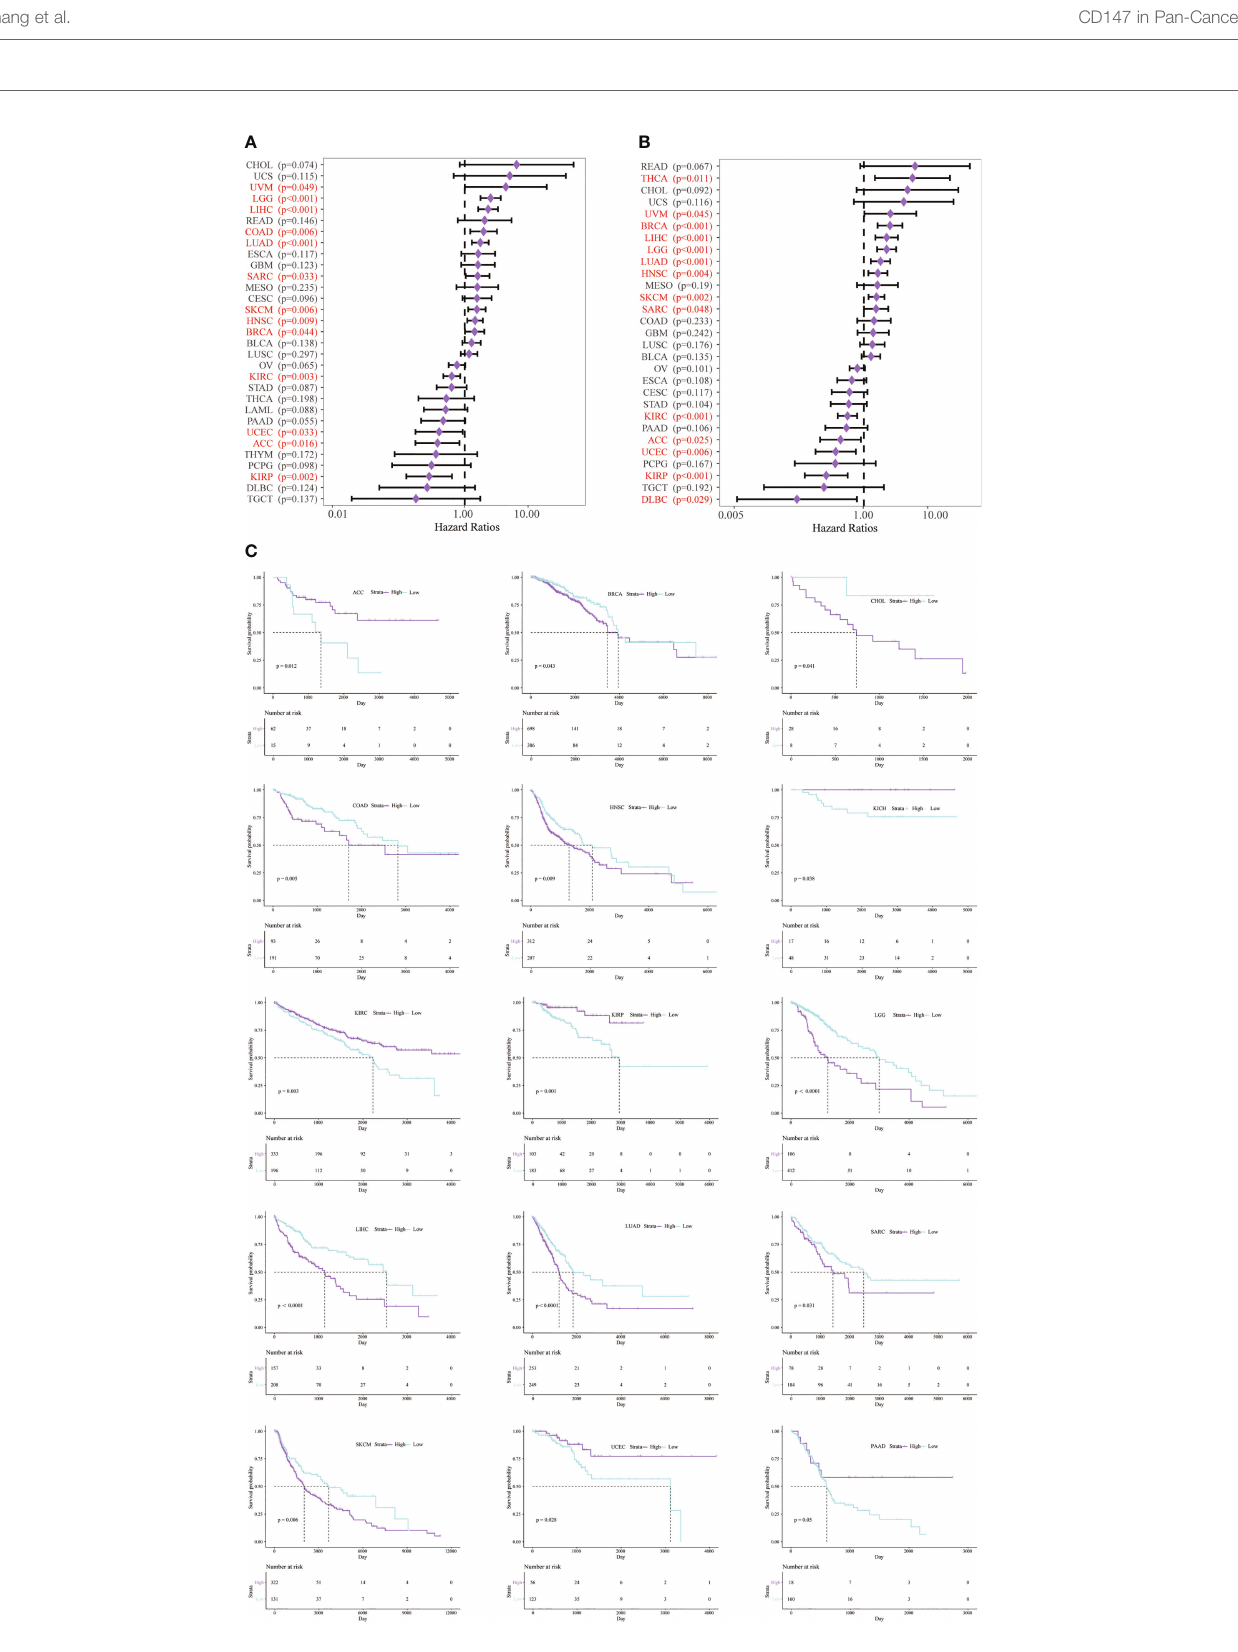
FIGURE 3 | Survival analysis of CD147 in pan-cancer from the TCGA database. Survival analysis of CD147 on OS (A) and DSS (B) in pan-cancer described by the forest plot. The prognostic value of CD147 on OS displayed by the KM method (C)